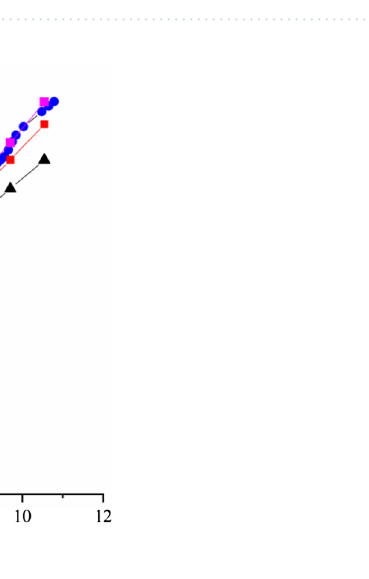
Figure 9. Curing temperature and concrete resistivity variation process under the variable-temperature curing conditions.